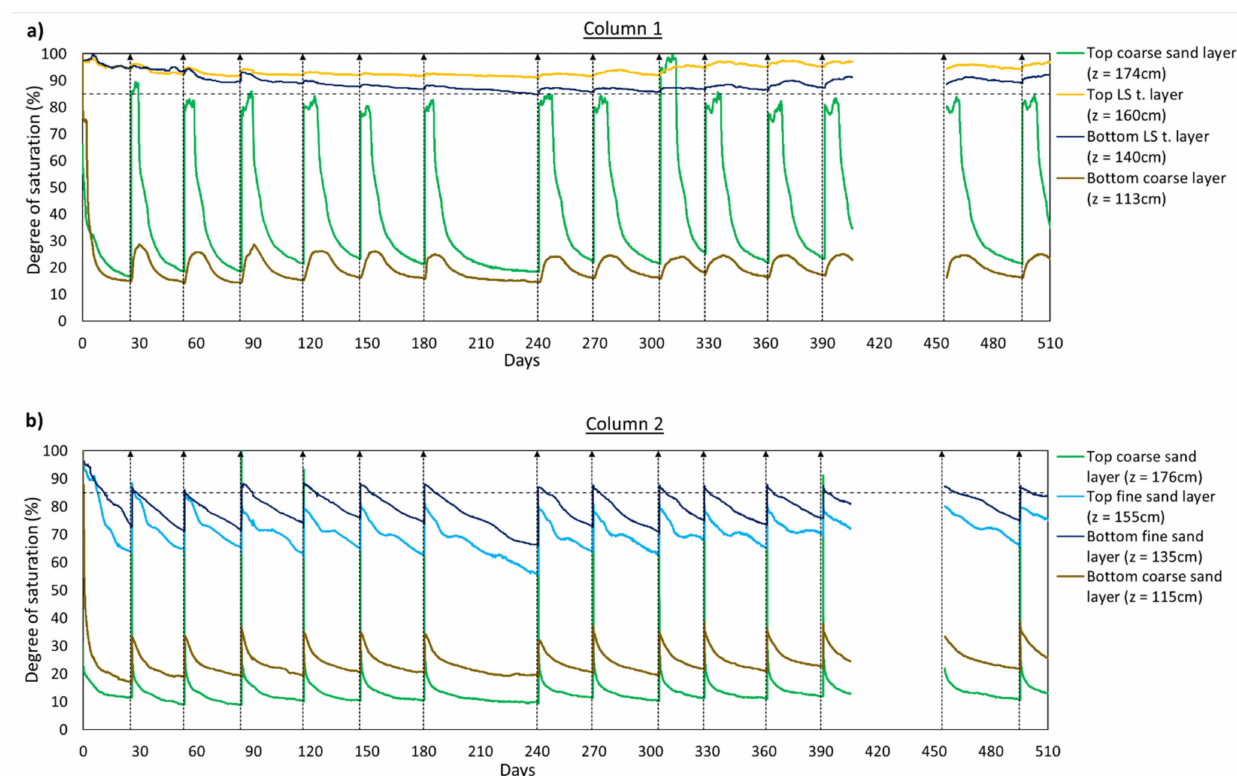
Figure 5. Variation of the degree of saturation with time for column 1 ( a ) and column 2 ( b ). The elevation z of the sensors in the column is indicated (also see Figure 4). Day 0 was 27 May 2016. The vertical dashed arrows mark the beginning of each wetting-drying cycle. Data acquisition stopped for 50 days between 7 July 2017 and 26 August 2017. The horizontal dashed line shows the usual performance target for the MRL, i.e., a degree of saturation of